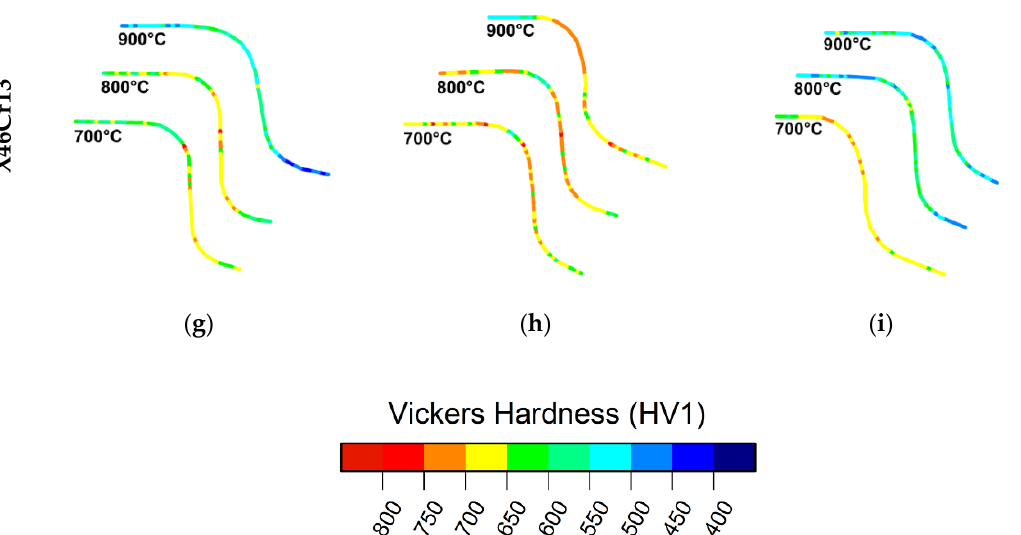
Figure 10. Resulting Vickers hardness profile of the deep drawn cups of the MSS alloys as a function of the austenization temperature T γ and dwell time t dwell for X12Cr13 ( a – c ), X30Cr13 ( d – f ) and X46Cr13 ( g – i ) depending from the austenitization treatment.